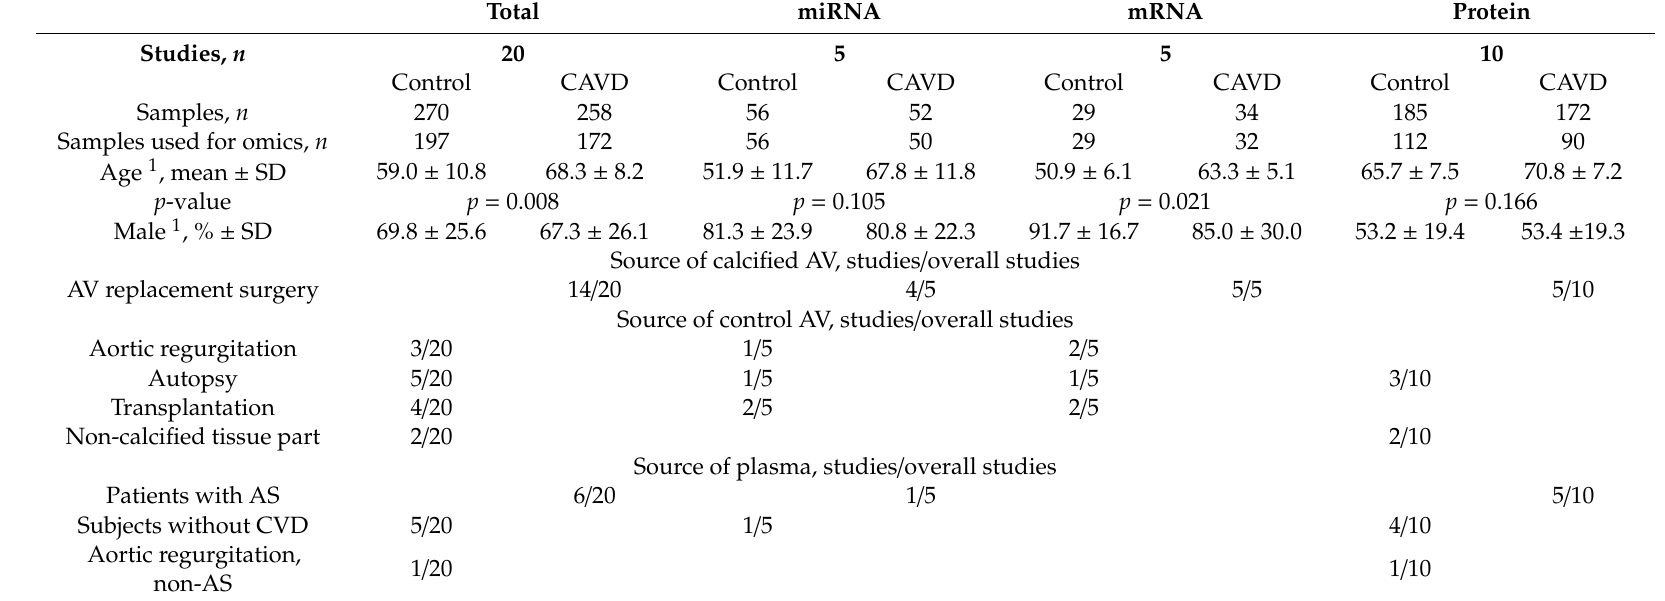
Table 1. Baseline